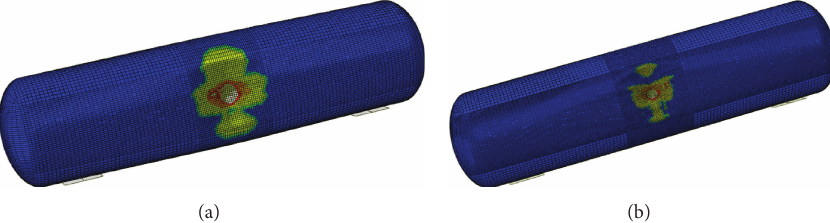
Figure 8: Illustration of the mesh size effects in the FE simulations of hazmat tank car using the local BCJ model. The figures show the damage pattern on the outer surface of the tank located in the impact region for a coarse (a) and fine (b) mesh at the same time. Note the difference between the damage pattern for the